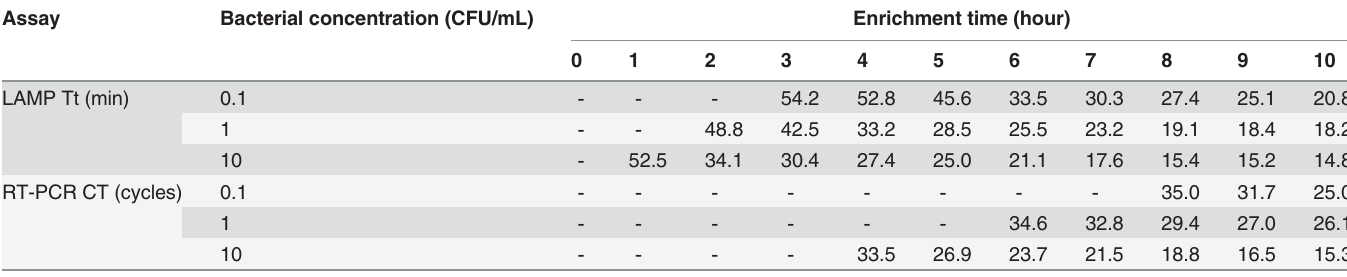
Table 4. A comparison of the LAMP and RT-PCR assays in human blood samples spiked with low levels of S . Typhi. Assay Bacterial concentration (CFU/mL)